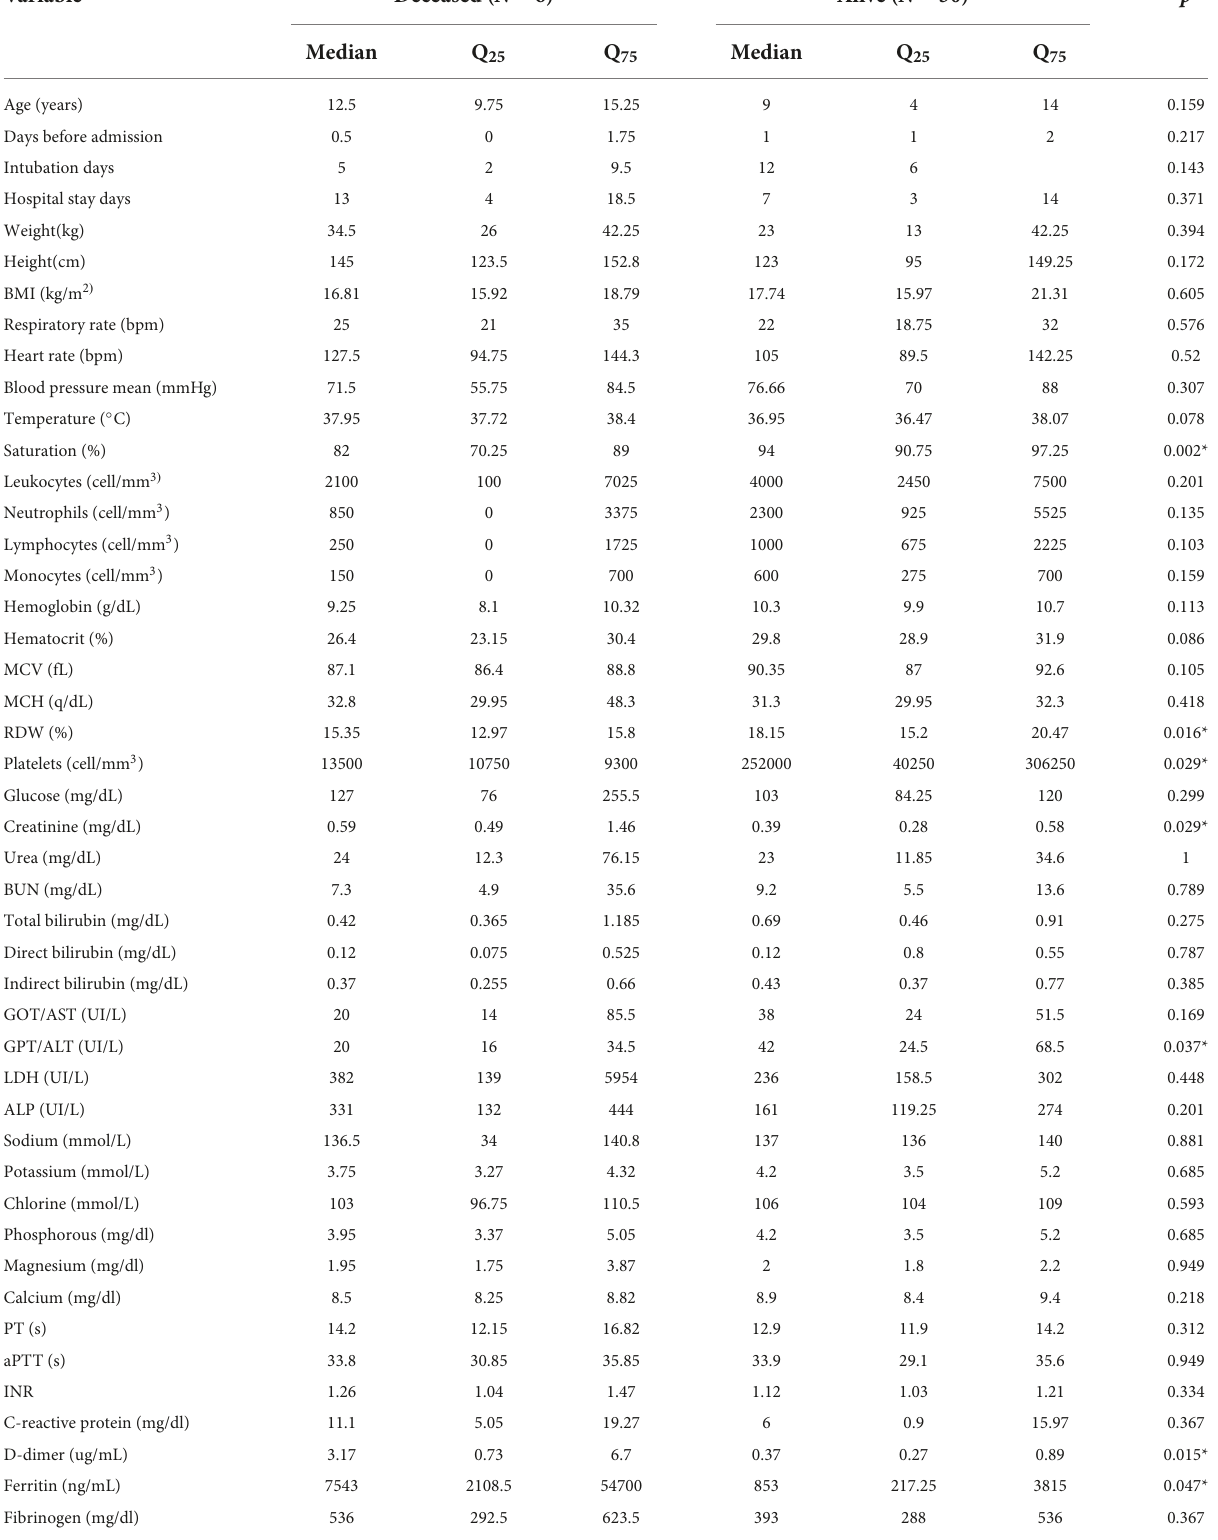
TABLE 5 Clinical and biochemical factors associated with mortality in oncological pediatric patients with COVID-19.